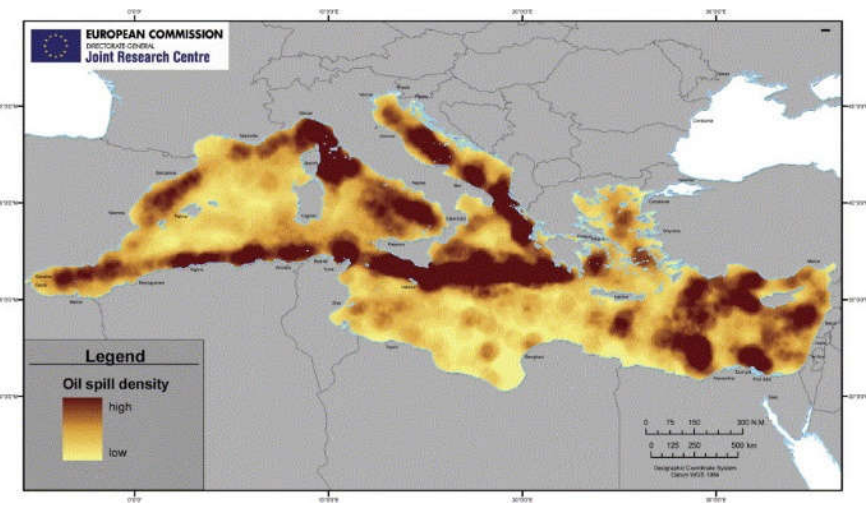
Figure 3. Oil spill density in the Mediterranean Sea [10].